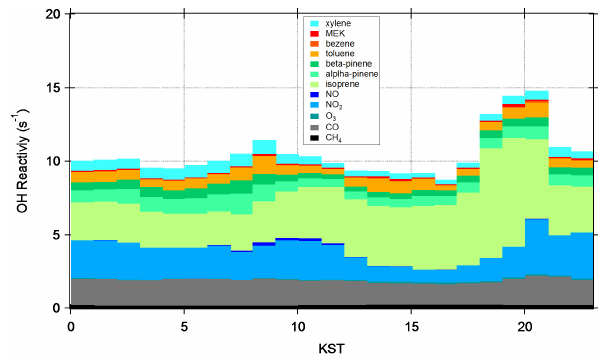
Figure 2. The temporal variations of OH reactivity calculated from the observed data set at TRF (Fig.